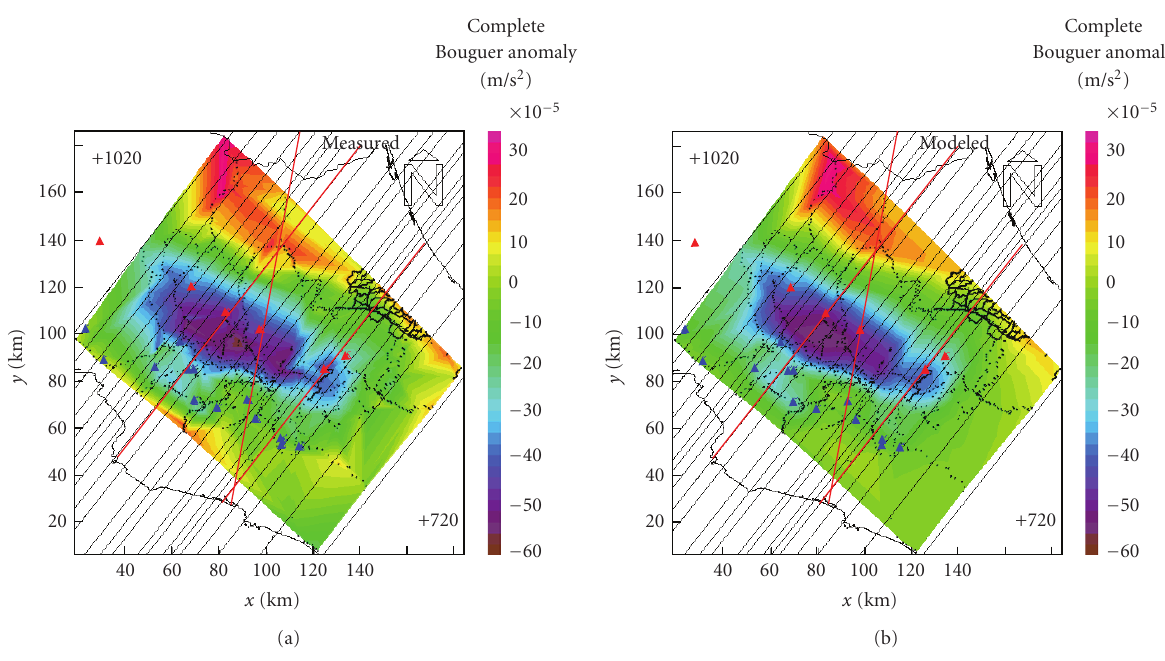
Figure 6: Comparison of measured (a) and calculated (b) complete Bouguer anomalies. Location and trend of model cross sections are shown as NE-SW trending black straight lines. The cross sections presented on this work are highlighted in red. Location of the main Quaternary volcanic vents are shown as red triangles. The Neogene “Aguacate” paleo-volcanic vents inferred from surface geology are shown as blue triangles. Black dots represent the location of gravity stations. Coastline and political borders are shown in bold black